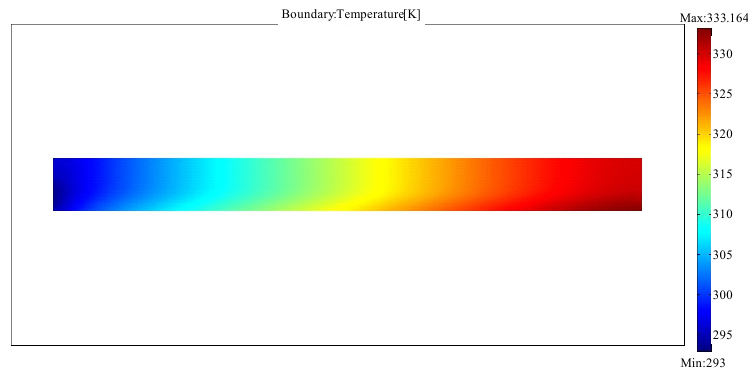
Figure 7. Temperature contour of the micro multi ‐ channel heat sink in Case 1.